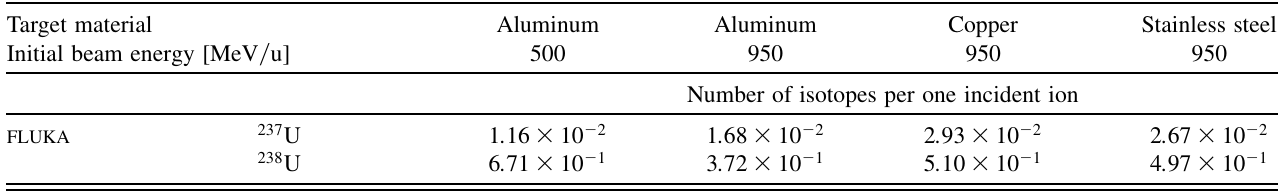
TABLE IV. Production of the 237 U fragments and conservation of the 238 U projectiles per one incident ion in aluminum, copper, and stainless-steel target calculated by FLUKA2011.2.3 . The initial energy of the primary ions was 500 and 950 MeV = u . The relative standard uncertainty of the presented data is below